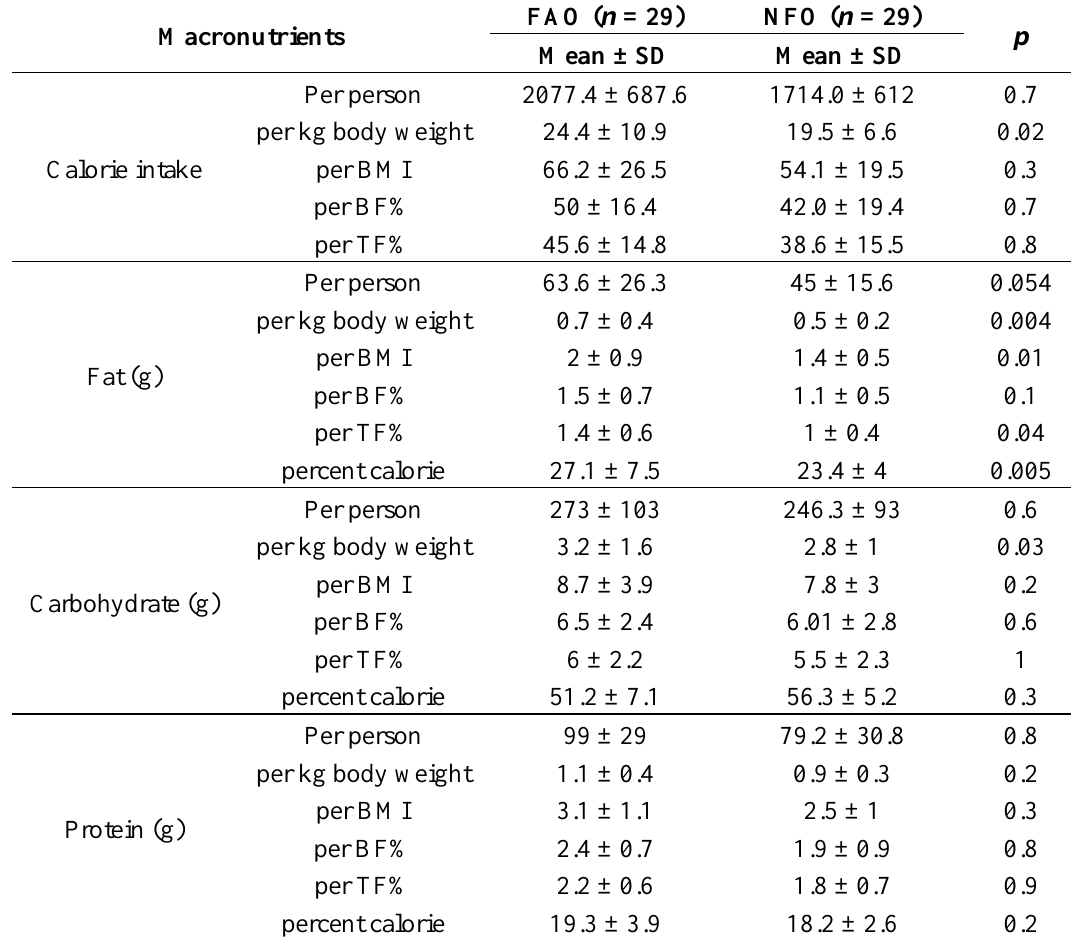
Table 3. Macronutrient intake characteristics in food addiction and non-food addiction overweight/obese groups *.